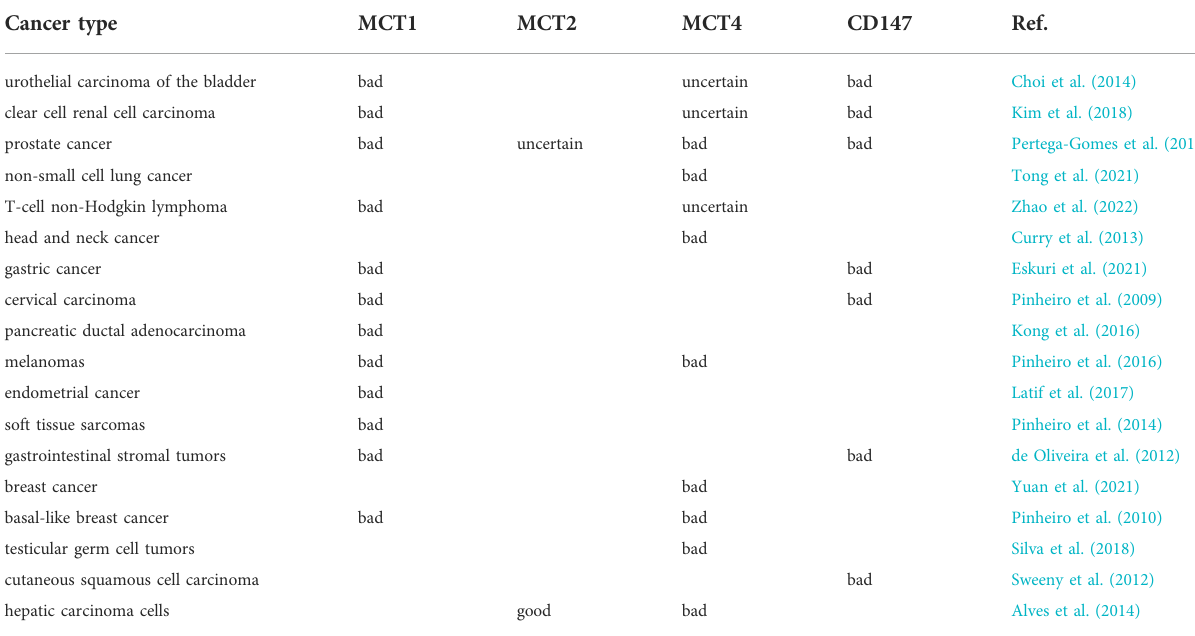
TABLE 2 Prognostic value of MCTs expression in human